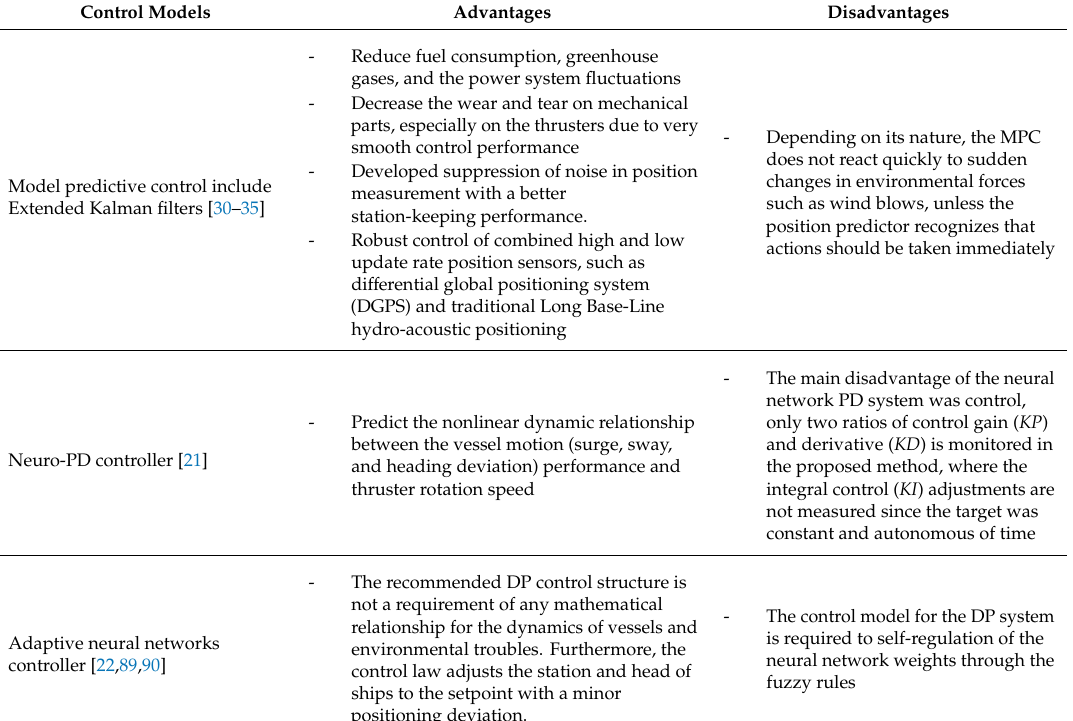
Table A4. Comparisons of DP control